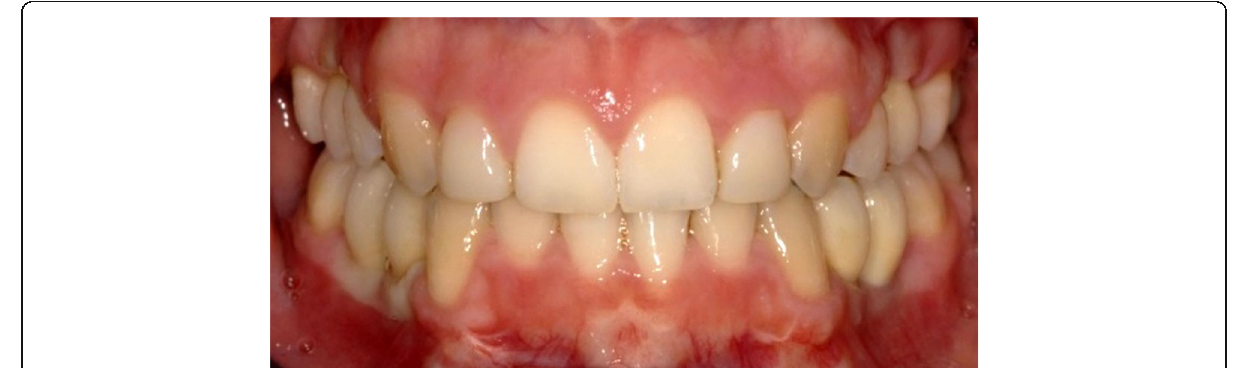
Fig. 9 Patient 1 — prosthodontic end result 5 months after implant